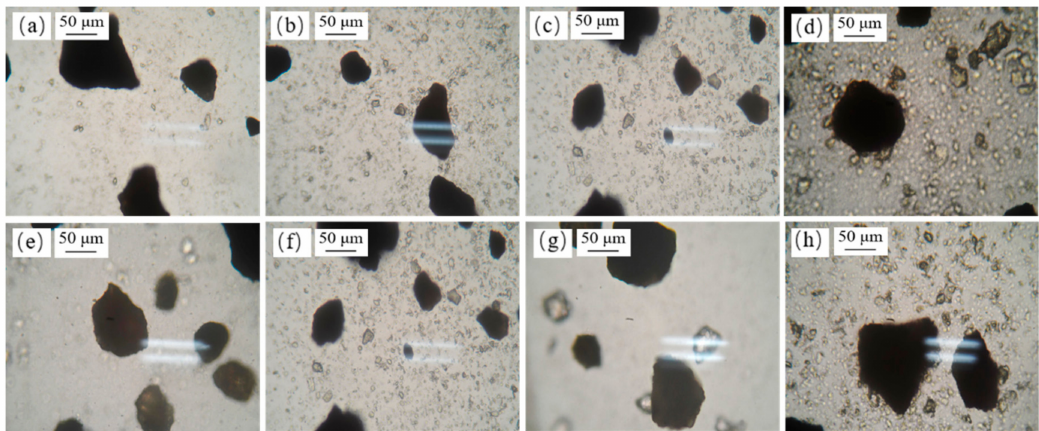
Figure 13. Dispersion and aggregation of fine minerals with pyrite or diaspore. ( a ) FDIA + Diaspore; ( b ) Kaolinite + Diaspore; ( c ) Illite + Diaspore; ( d ) Pyrophyllite + Diaspore; ( e ) FDIA + Pyrite; ( f ) Kaolinite + Pyrite; ( g ) Illite + Pyrite; and ( h ) Pyrophyllite +